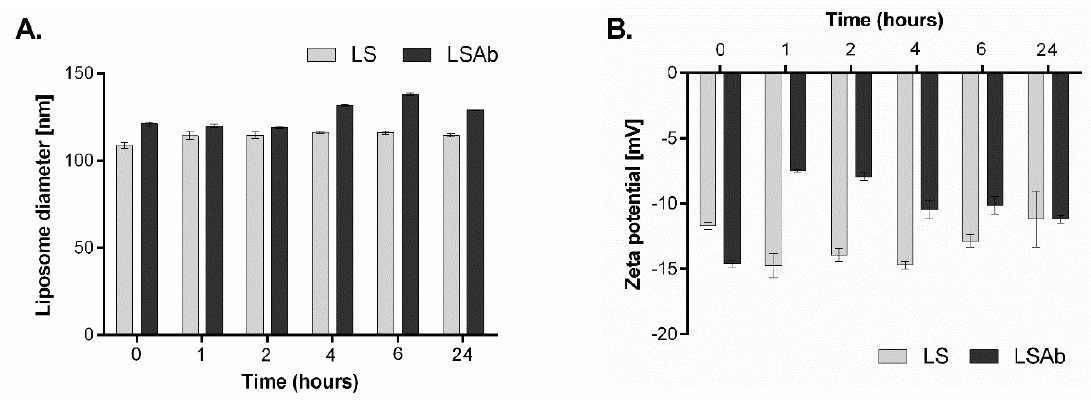
Figure 3. Stability of simvastatin liposomes and immunoliposomes upon incubation with human plasma. Simvastatin liposomes and immunoliposomes were incubated with 50% human plasma at 37 ◦ C. After indicated time period, changes in liposomes diameter ( A ) and zeta potential ( B ) were measured.